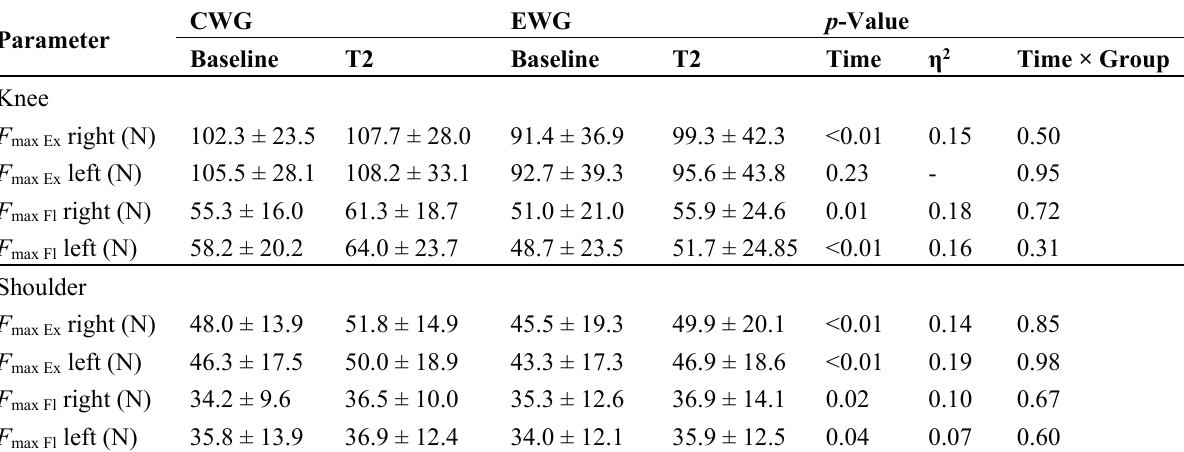
Table 3. Isokinetic parameters at baseline and after training